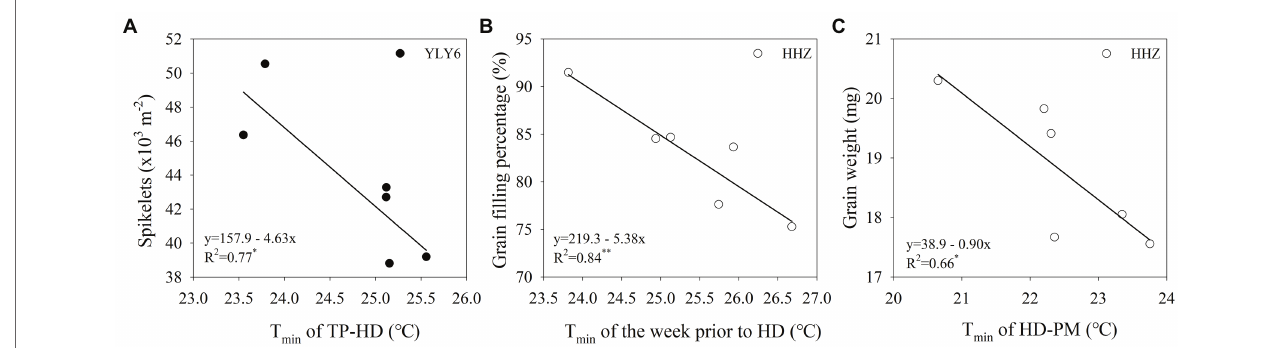
FIGURE 7 | The relationship between spikelets m − 2 and T min of transplanting (TP) to heading (HD) for YLY6 (A) , between grain filling percentage and T min of the week prior to HD for HHZ (B) , and between grain weight and T min of HD to maturity (PM) for HHZ (C) . * and ** are statistically significant at the p ≤ 0.05 and p ≤ 0.01 probability level according to the Student’s t test, respectively. The regression equations are not shown in the graphs when the correlations are not significant. T min – the growing-season mean minimum